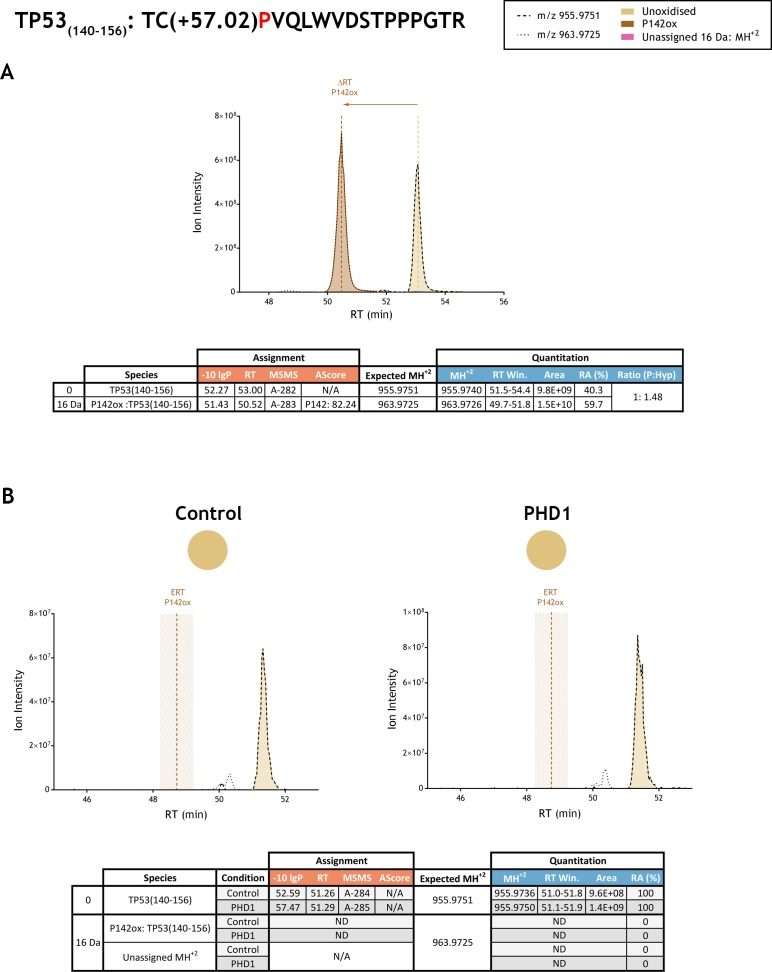
Quantitation of peptide oxidation on TP53(140-156) following reaction of full-length tumour protein p53 with recombinant PHD1.XIC data presented in (A) shows ion intensity and retention time (RT) characteristics of equimolar synthetic peptide standards for unoxidised and P142ox forms of the TP53(140-156) peptide. MSMS assigned species are coloured (see inset); vertical dashed lines define peak maxima used to derive ΔRT values for P142ox. Panel (B) shows comparable XIC data for protease-digested IVTT substrate under control (left) or PHD1-reacted (right) conditions. Peaks corresponding to unoxidised TP53(140-156) were assigned by MSMS (see inset for colour code); P142ox was not detected. The estimated RT (ERT) for P142ox, derived from (A), is indicated by dashed vertical line, shading corresponds to a 1 min RT window. Note, unshaded peaks (at RT: 50.5 min) corresponding to m/z 963.9725 are unrelated ions based on isotopic profiles (different monoisotopic mass and/or charge) observed in LC-MS data. Unassigned ions of compatible mass over charge for hydroxylation were not observed across the elution window. Quantitative data for observed species are presented as pie charts with XIC data. Assignment and quantitation data are tabulated below each panel, table headers are as follows: (−10lgP) significance score of leading assignment at given (RT) with ambiguity score (AScore) for PTM localisation and reference to primary MSMS data in Supplementary file 1. Quantitative data reports ion counts (Area) of observed masses (MH+2) integrated over time (RT Win.), expressed as relative abundance (RA). Data on detection efficiency for synthetic peptides (Panel A, P: Hyp) is an aggregated ratio of prolyl (P) to hydroxyprolyl (Hyp) containing species.